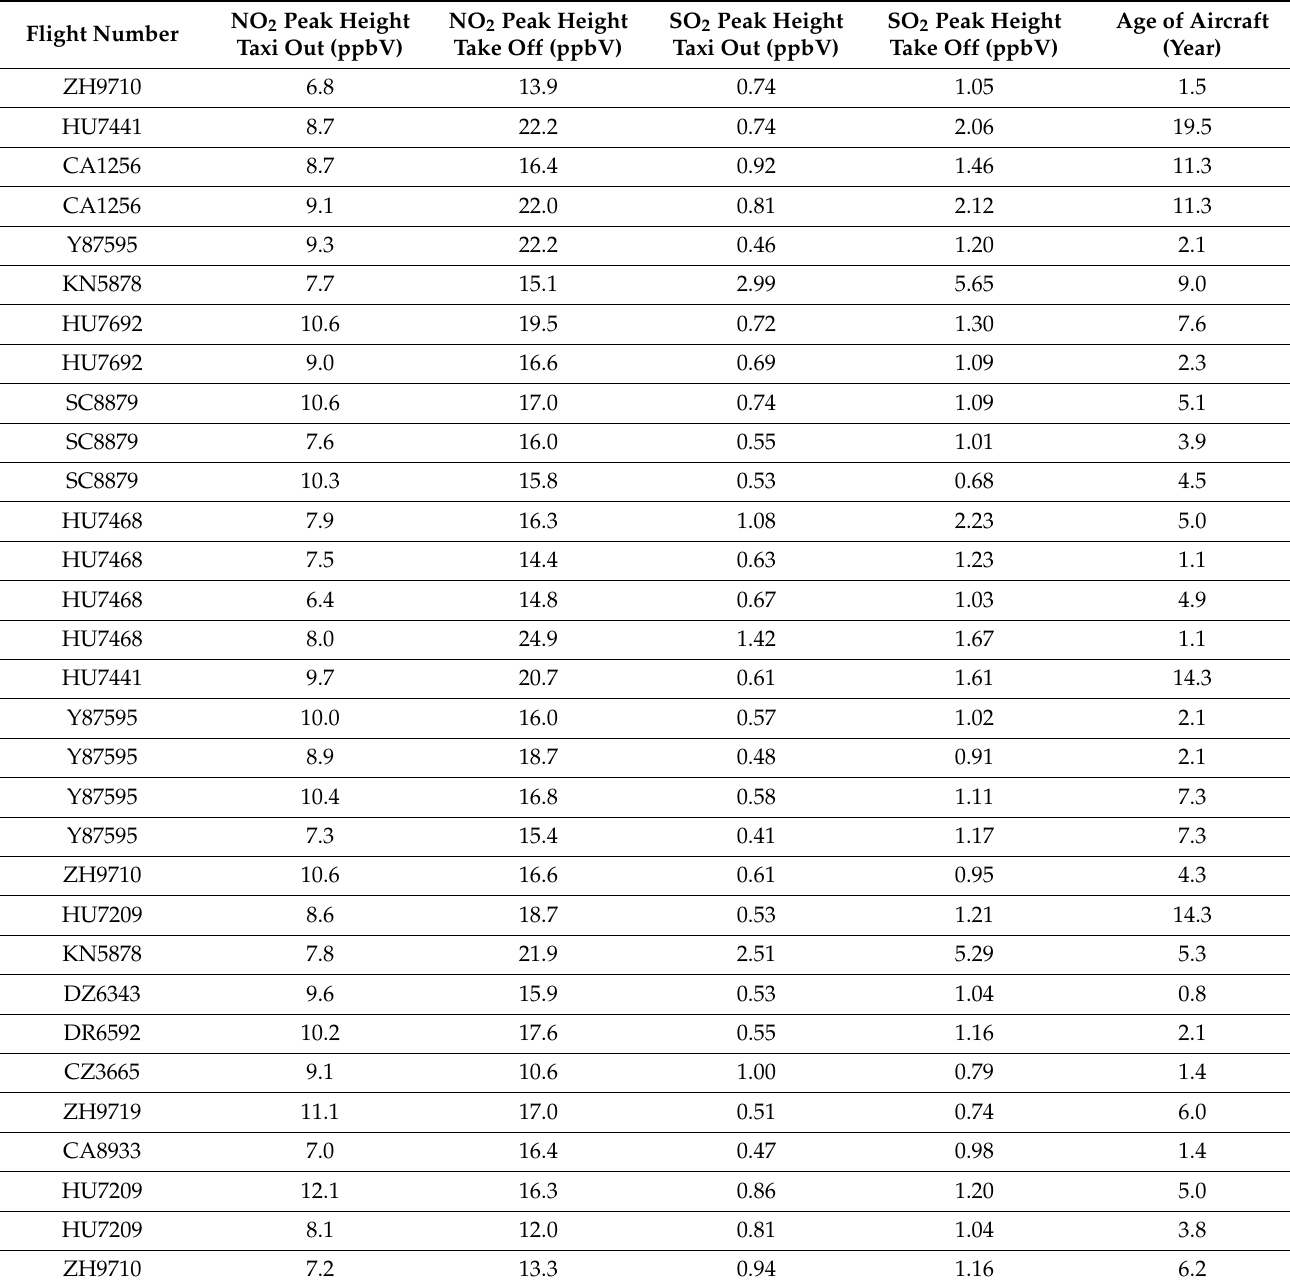
Table 1. Results for the Boeing 737–800